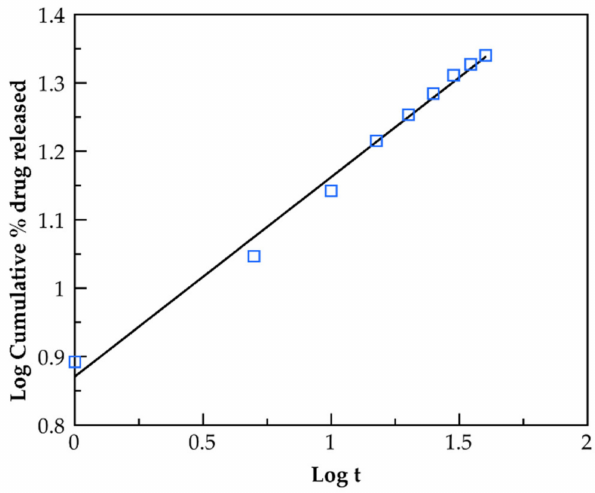
Figure 15. Fit of experimental data of hydrocortisone release for PMAA-G 3.0 -CNTs 1 ( Korsmeyer–Peppas model (solid